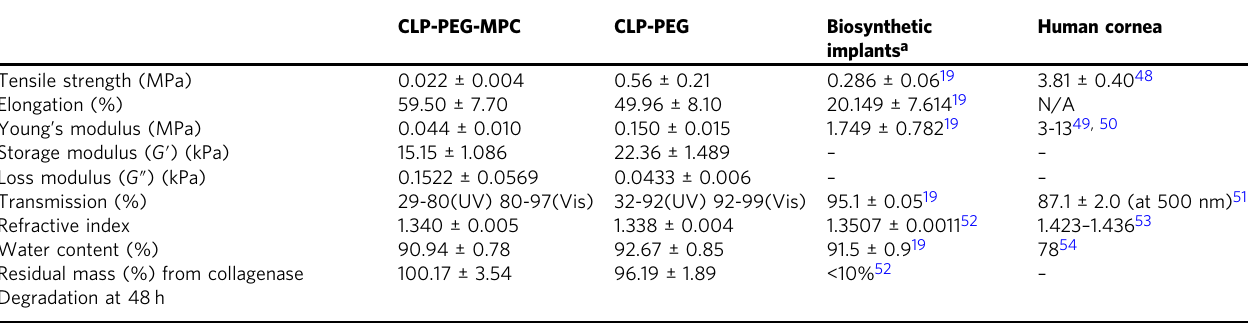
Table 1 Characterization of CLP-PEG-MPC hydrogels compared to CLP-PEG only hydrogels, biosynthetic implants currently in patients and the human